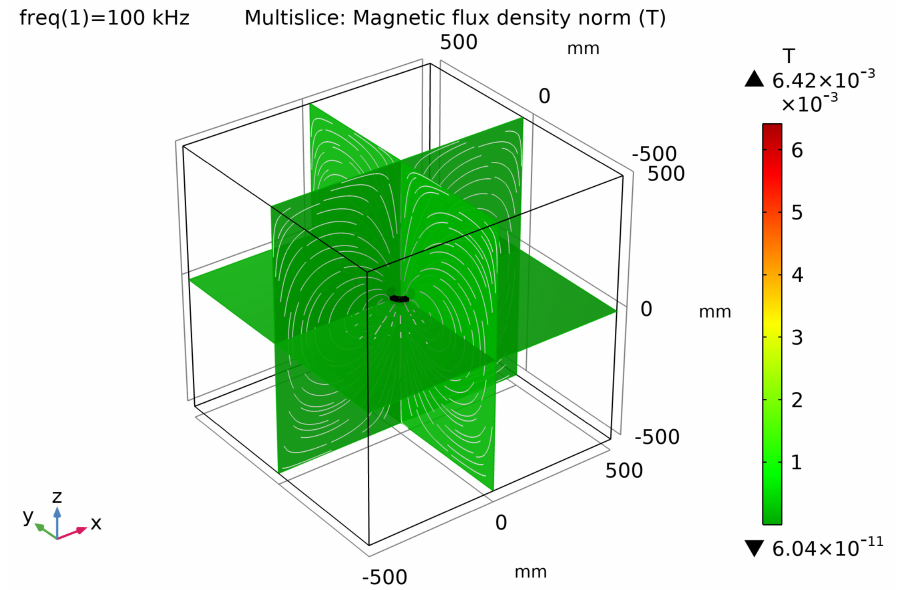
Figure 15. Leakage magnetic flux distribution in the whole model, including the air domain at the full-load condition and 100 kHz.